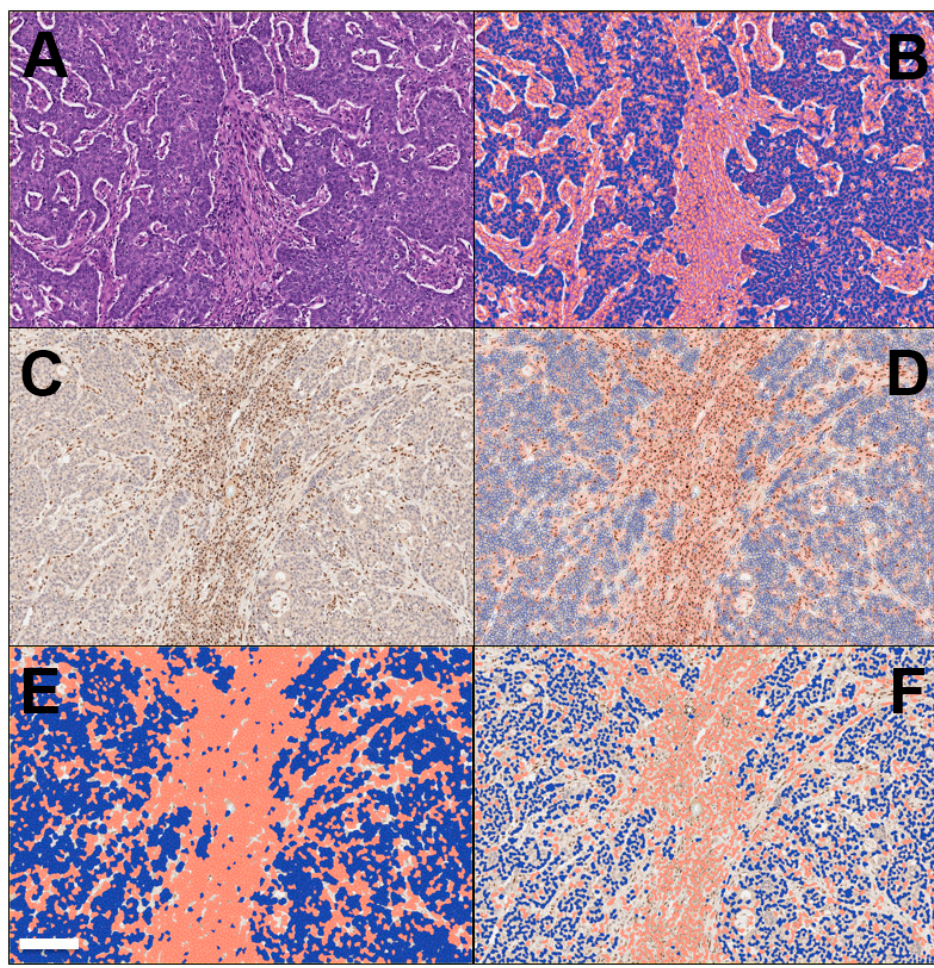
Figure 3. Representative workflow of the digitalization of a case of colon cancer with microsatellite instability is provided here (provided by Claudio Luchini, co-author). ( A ) Cancer area: tumor cells and peri-tumor cells, including stromal cells and immune cells, are here shown. This is the point of the start of the analysis on a slide stained with hematoxylin-eosin (original magnification: 10 × ). ( B ) The digitalized system is able to separate cancer cells (here colored in blue) from non-cancer cells (red). ( C ) The immunohistochemistry for mismatch-repair proteins can be also taken into account in this process. This figure represents MSL-staining, showing the loss of the protein into the neoplastic component, while its expression in retained in non-tumor cells (original magnification: 10 × , same field of hematoxylin-eosin). ( D ) The digitalized system is able to interpret the results of immunohistochemistry, based on a deep learning approach. In this step, the system shows its ability to separate cancer cells (here colored in blue) from non-cancer cells (brown). ( E , F ) Since the immunohistochemistry for mismatch-repair proteins is a nuclear staining, for finalizing its interpretation the system here shows its ability in the detection and analysis of only cell nuclei, with tumor cells in blue and non-tumor cells in red ( E , F ; different resolution of analysis, which can be adapted based on staining patterns and the difficulty of their interpretation). Scale